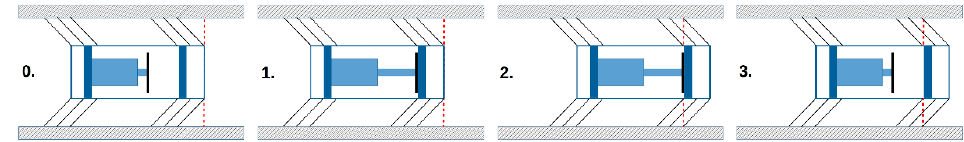
Figure 1 . Motion phases of the proposed robot . Figure 1. Motion phases of the proposed